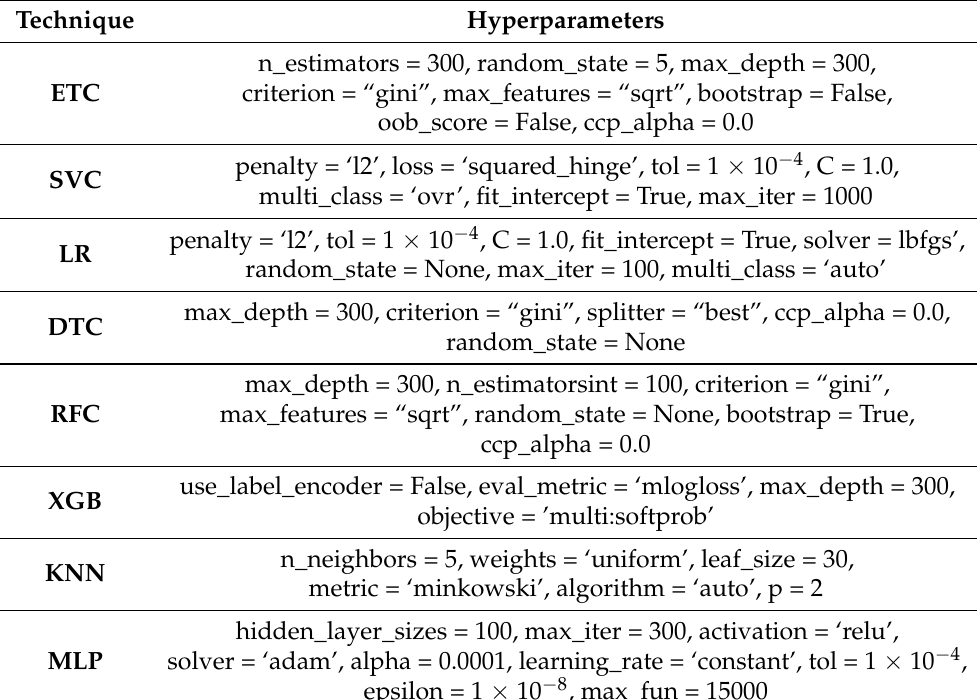
Table 3. Configuration of hyperparameters for employed machine learning